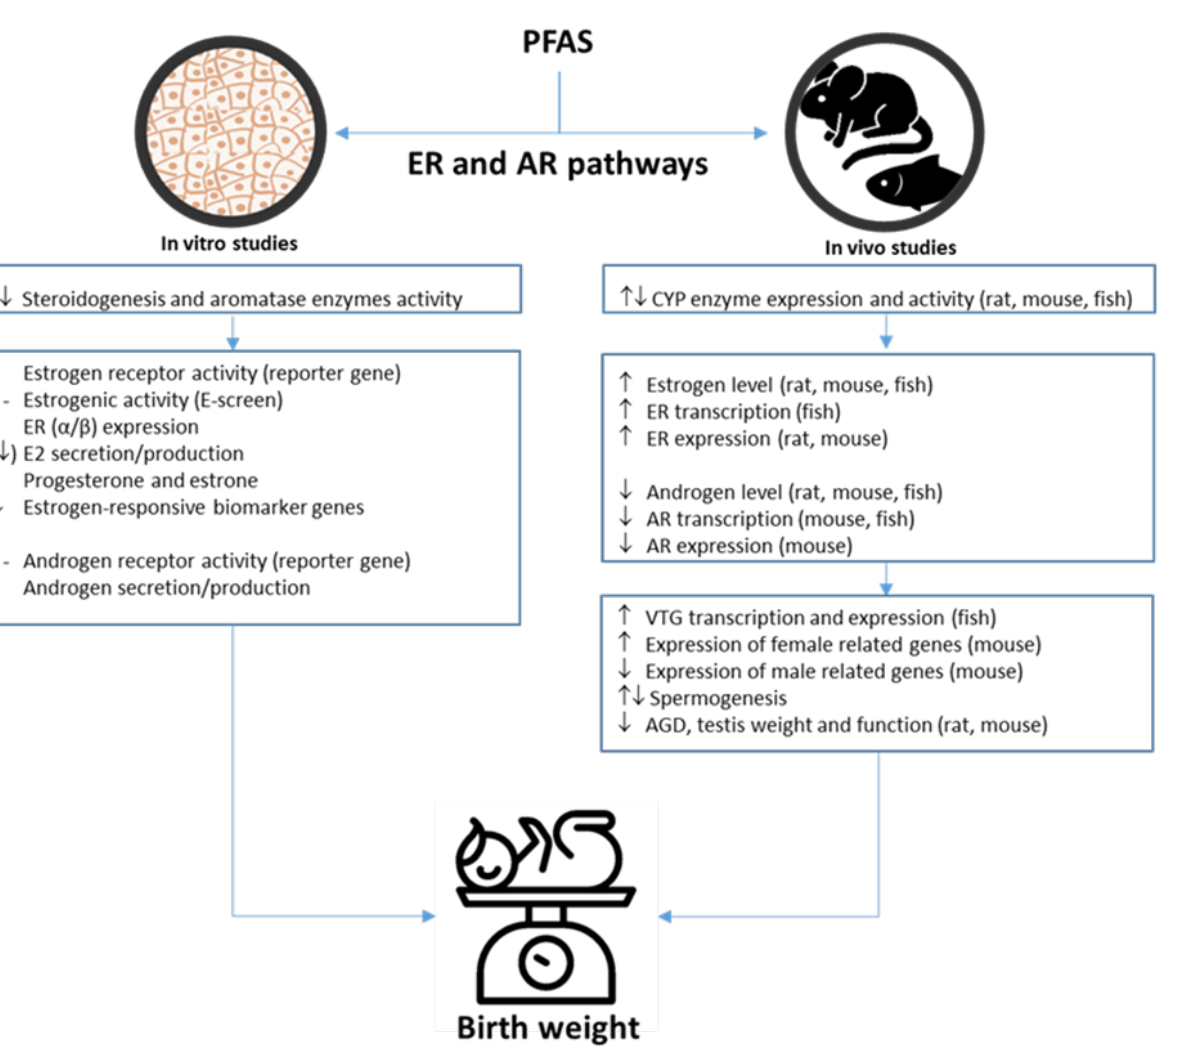
Figure 4. Possible PFAS-induced estrogenic and androgenic effects involved in birth weight. PFAS, per- and polyfluoroalkyl substances; ER, estrogen receptor; AR, androgen receptor; VTG, vitellogenin; E2, estradiol; AGD, anogenital distance .